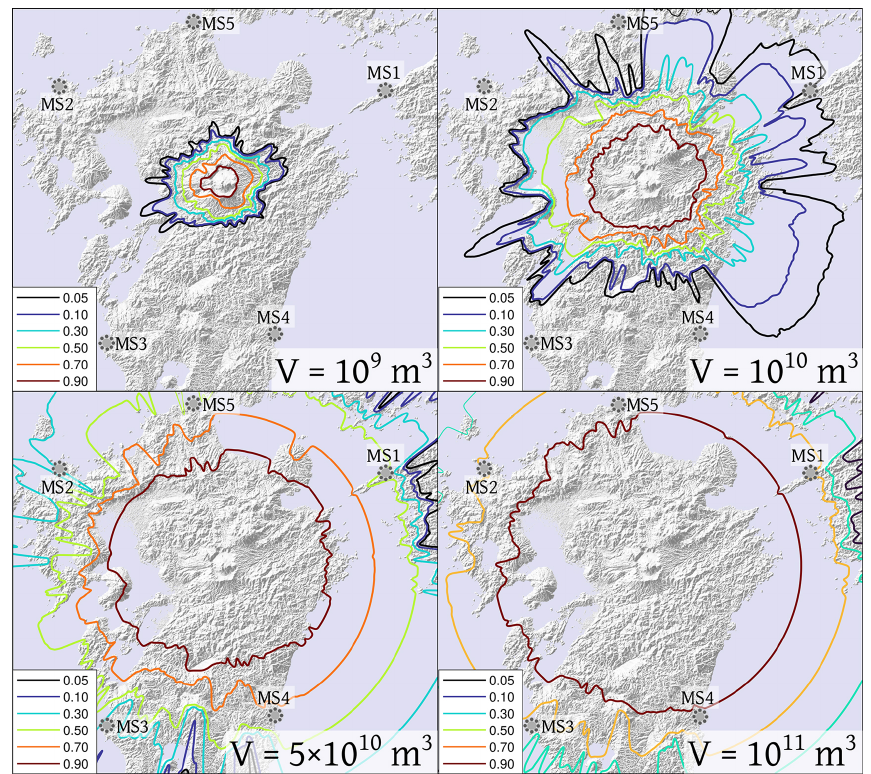
Figure 2. Probabilistic PDC invasion maps for four sets of simulations ( N = 1000 each run) with different values of collapsing volume and vent positions sampled uniformly within Aso caldera. The other input parameters are derived from expert judgment (see Table 1). These simulations were performed using the program BoxMapProb (Aravena et al., 2020; excluding tree-branching effects), which adopts the formulation of model 2c. Dotted gray circles mark the positions of the five marker sites. Contour lines show the invasion probability values in the lower left box. SRTM – DEM 1arcsec 30m (NASA,